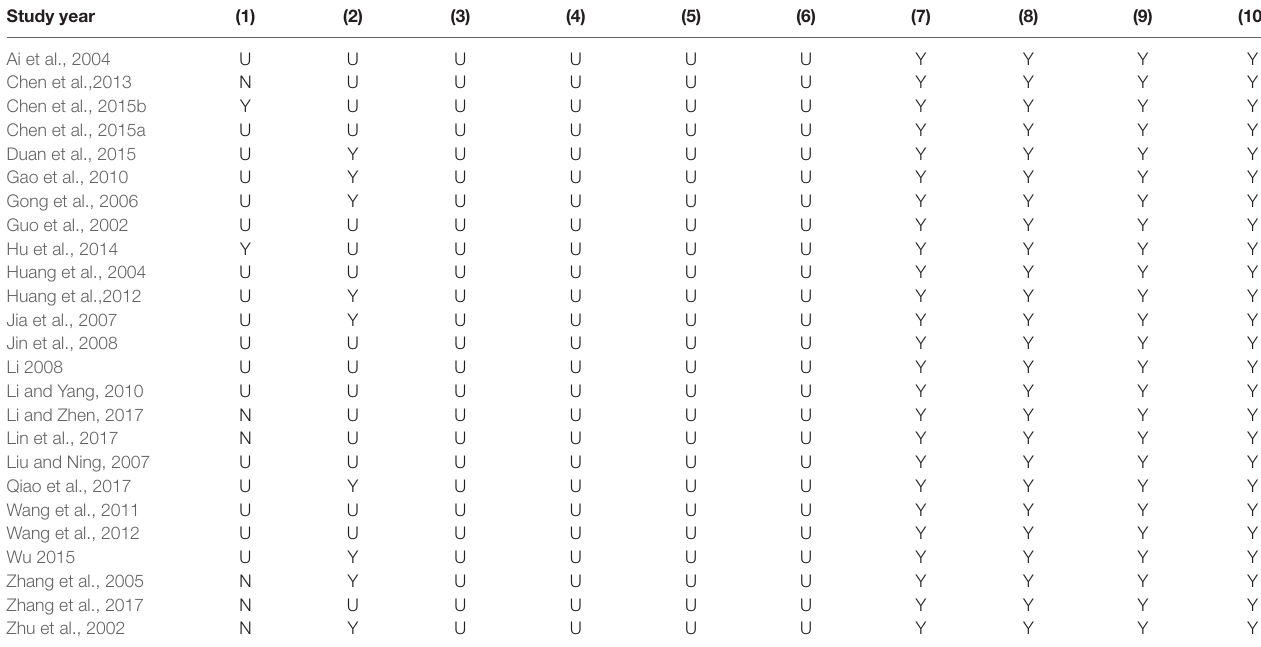
tABLe 2 | Risk of bias of included